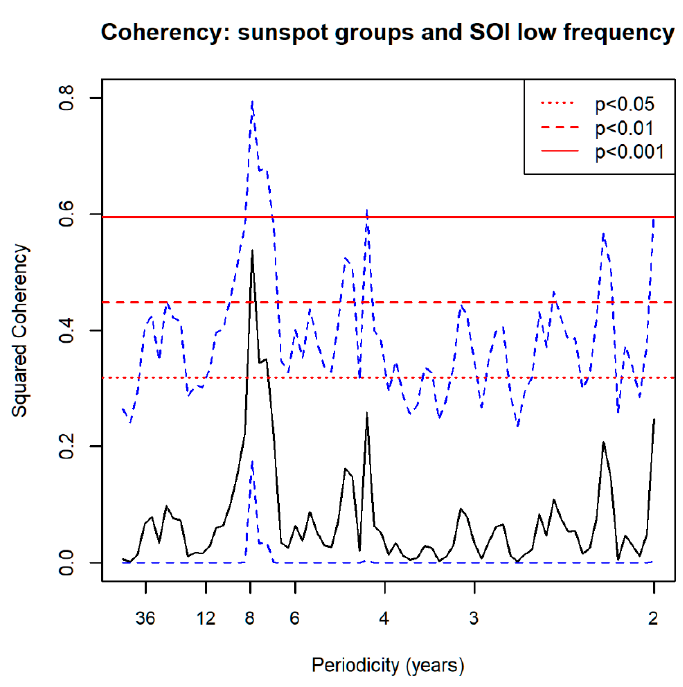
Figure 8. Spectral coherence between sunspot groups and the low frequency component of the SOI (SOIlf). The solid horizontal red line indicates significance at p = 0.001, dashed line p = 0.05, dotted line p = 0.05. The blue dashed lines represent 95% confidence intervals.